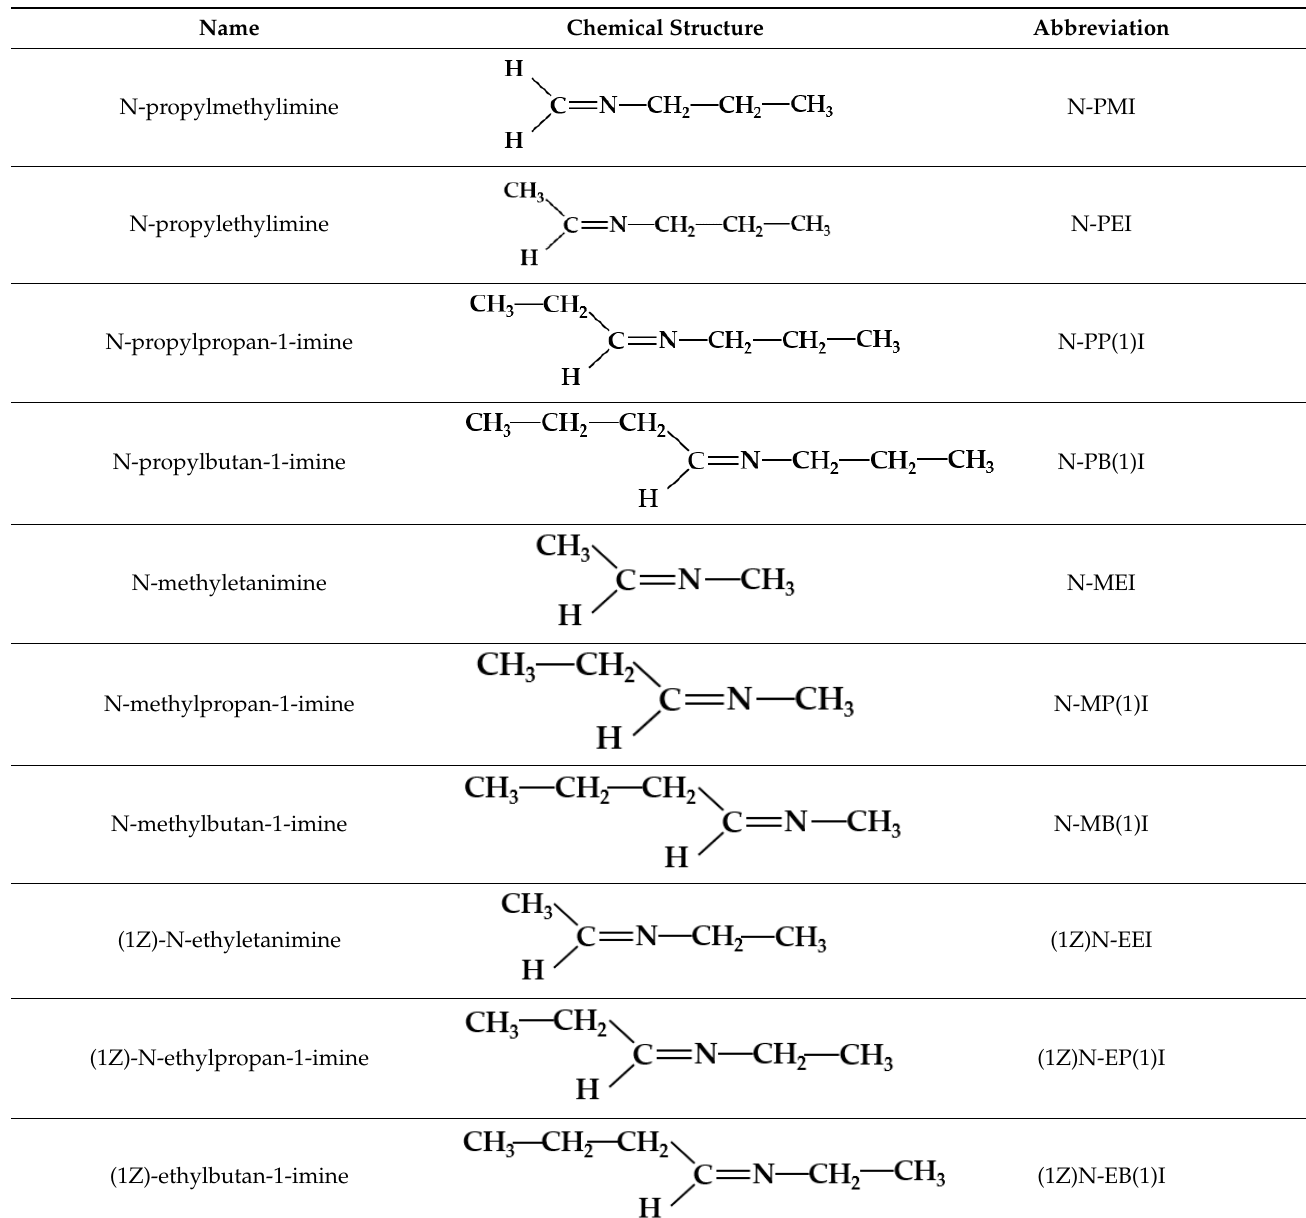
Table 1. Chemical names, structures and abbreviations of the new corrosion inhibitors investigated in the paper.